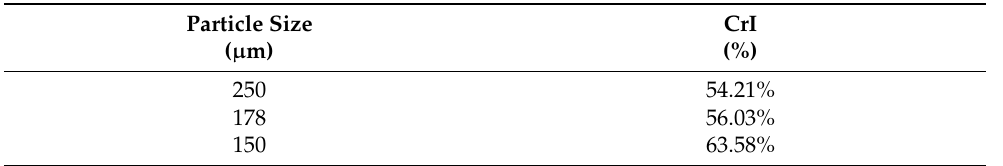
Figure 4. XRD spectra: (a) 250 µ m cellulose; (b) 178 µ m cellulose; (c) 150 µ m cellulose. Table 3. The crystallinity of cellulose extracted from different particle sizes of Neosinocalamus affinis powder.